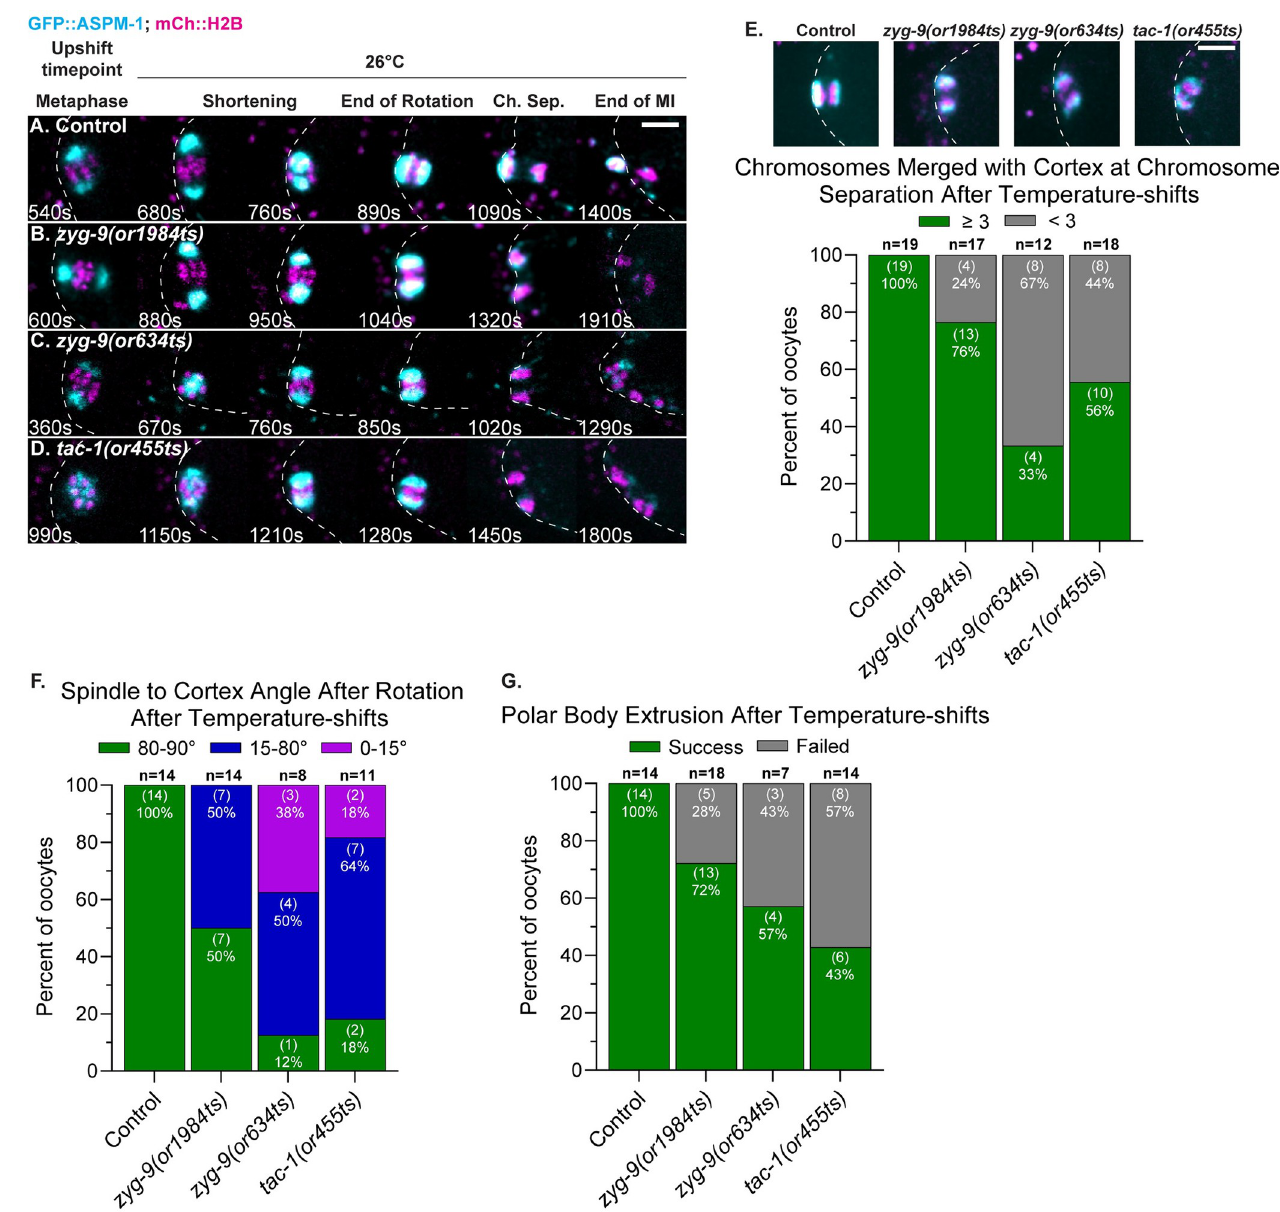
Fig 7. ZYG-9 and TAC-1 are required for meiosis I anaphase spindle rotation and polar body extrusion. (A-D) Time-lapse maximum intensity projection images of live control and TS mutant oocytes expressing GFP::ASPM-1 and mCherry::H2B upshifted at meiosis I metaphase; polar body extrusion failed in all three mutant oocytes. Oocytes were rotated so that the cortex was positioned to the left of the spindle; dashed lines depict the oocyte cortex. (E) Early anaphase time-lapse images of live control and TS mutant oocytes after metaphase upshifts. Bar graph quantifies spindle rotation based on the number of chromosomes adjacent to the cortex at the start of chromosome separation in metaphase upshifted oocytes (see Materials and Methods). (F) Spindle angles relative to the cortex at early anaphase in metaphase upshifted oocytes. (G) Number of control and TS mutant metaphase upshifted oocytes that extrude a polar body during meiosis I (see Materials and Methods). Scale bars = 5 μ